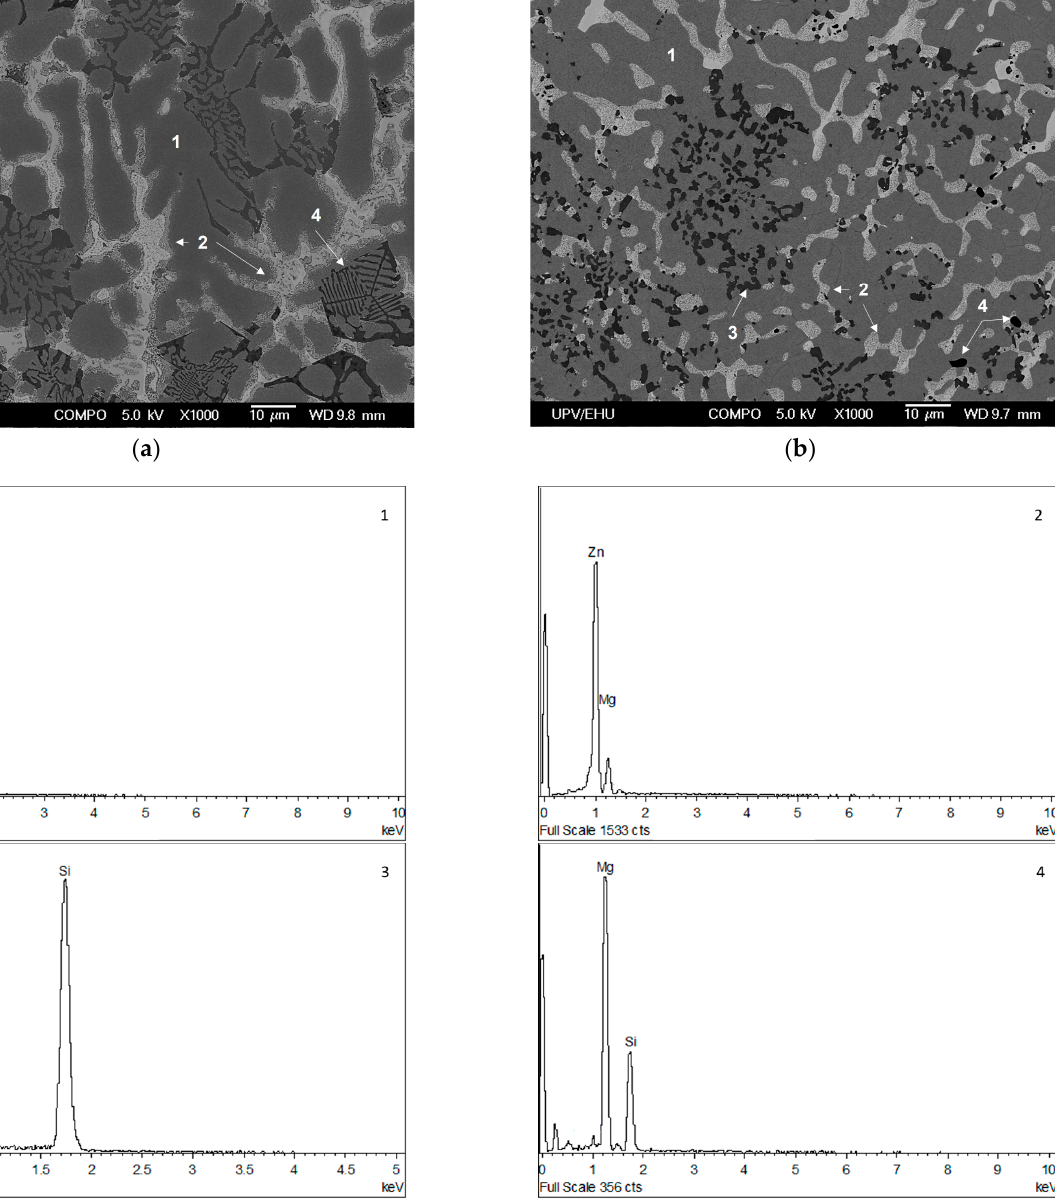
Figure 5. SEM micrographs of the material with x1000 magnification ( a ) As-cast. ( b ) Q380. Numbers 1 to 4 refer to the EDX results provided below. 1: Al-Zn matrix, 2: Mg-Zn phases, 3: Si phases and 4: Mg-Si phases.